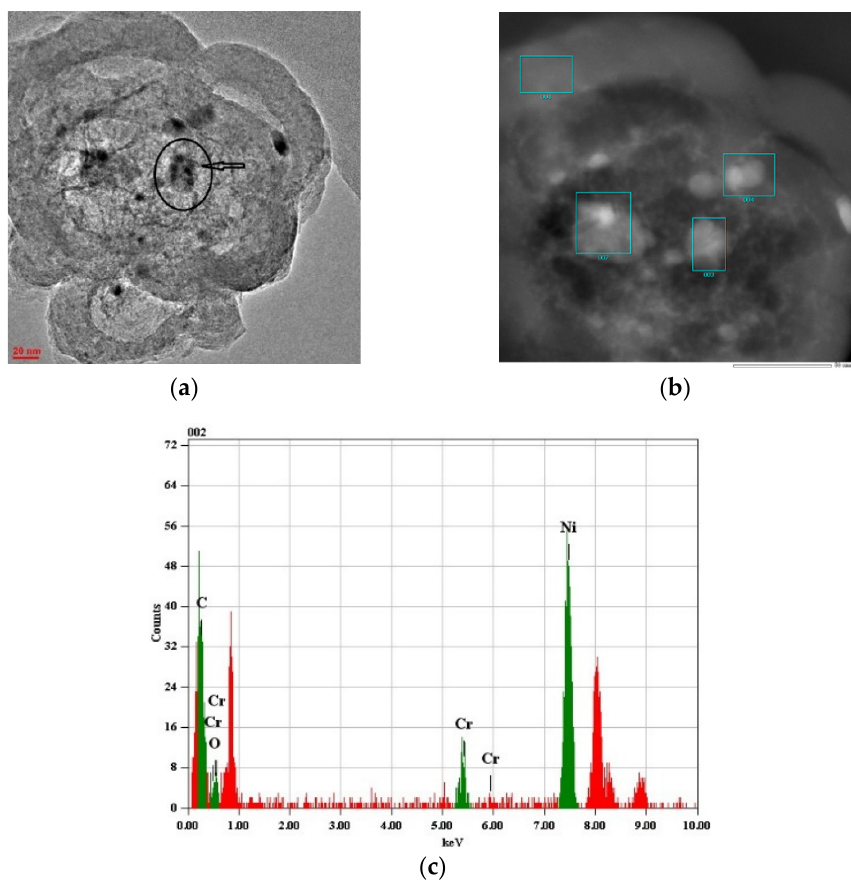
Figure 1. Catalyst (3Ni-1.5Cr)/C: micrograph in light ( a ) and dark field ( b ) with EDX ( c ). Comparison with other investigated Ni-Cr systems indicates that the order of the application of metals does not have a noticeable effect on the change in the average size and distribution of particles on the surface of the sibunite. At the same time, the presence of Cr x Ni 1 − x solid solutions with different Cr/Ni ratios, as well as small amounts of NiCrO 4 with a rutile structure and NiCr 2 O 4 with a spinel structure, is determined at the points of contact of the two metals at interplanar distances. Interestingly, the formation of the latter, together with a decrease in the degree of oxidation of the catalyst surface due to the alloy- ing of nickel with chromium, is indicated as a possible reason for an increase in the activity of the PtNiCr system in the electrooxidation of methanol compared with a monometallic Pt catalyst [7,8]. It was shown [11–13] that the substitution of chromium for Mn and Co also affects the activity of the Ni-Mn and Ni-Co binary systems; however, the effect is less pronounced. In order to identify the forms of nickel and chromium in the catalysts under study, the corresponding samples were examined using X-ray photoelectron spectroscopy (XPS). The comparison showed that the XPS spectra of all the analyzed systems, regardless of the order of application of metals, are identical and have no fundamental differences among themselves. In particular, only a doublet of broad lines with a poorly expressed structure and with a binding energy of the Cr 2p 3/2 component of about 577.0 eV, which is typical for trivalent chromium compounds, is observed in the Cr 2p spectra of all the sam- ples studied [22]. In the Ni 2p spectra of the studied samples, a small shoulder with a binding energy of about 852.7 eV is observed, which indicates the presence of metallic nickel [23]. At the same time, the main contribution to the Ni 2p spectrum is made by the oxidized state of nickel, which corresponds to the Ni 2p 3/2 component with a binding en- ergy of about 855.8 eV and an intense shake-up satellite, which is characteristic of divalent nickel [23]. The result of deconvolution of the spectra by the example of the catalyst (3Ni- 3Cr)/C is shown in Figure 2 and in Table 1. The proportions of nickel in various states in this catalyst are indicated in comparison with the most characteristic data for other stud- ied Ni systems.